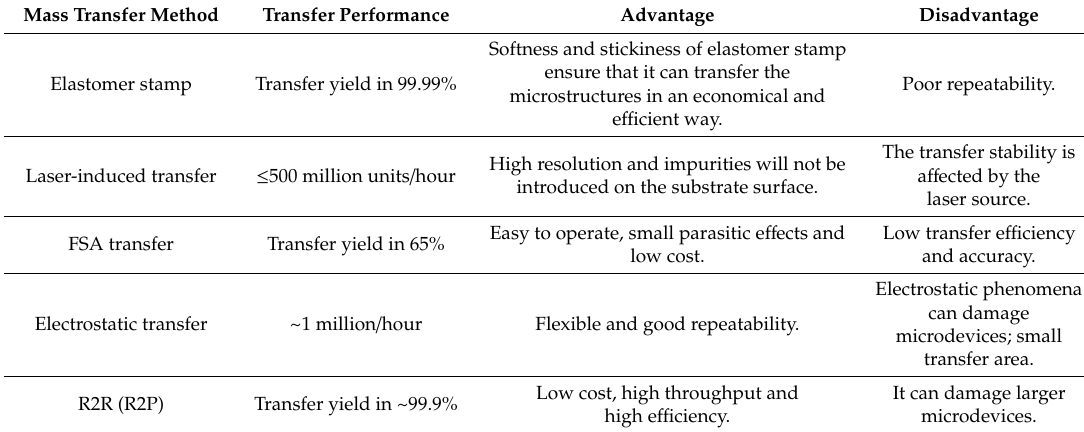
Table 2. Comparison of various mass transfer technologies.